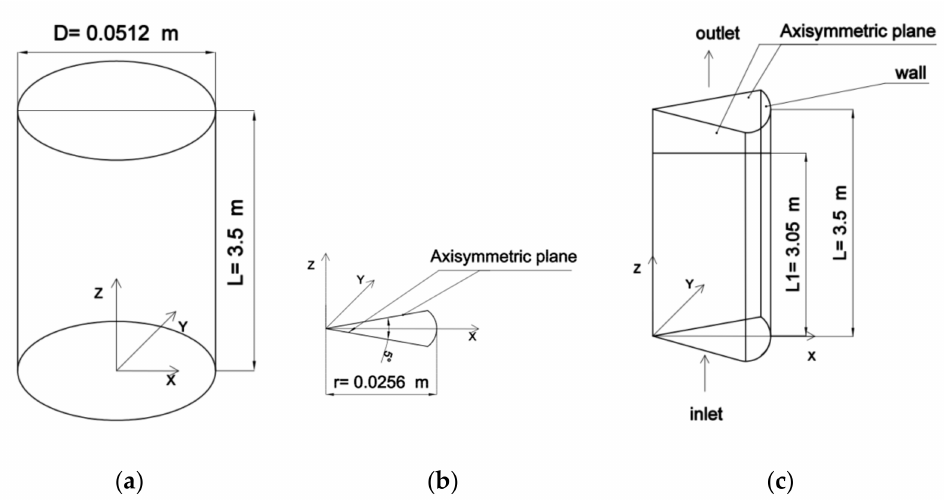
Figure 4. Schematic diagram of the computational domain. ( a ) Whole flow field of the